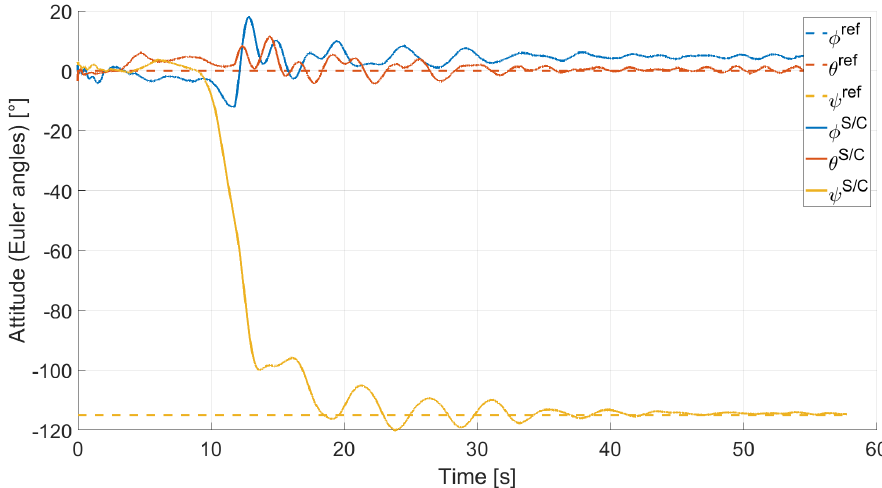
Figure 13. Case 1: attitude as Euler angles.